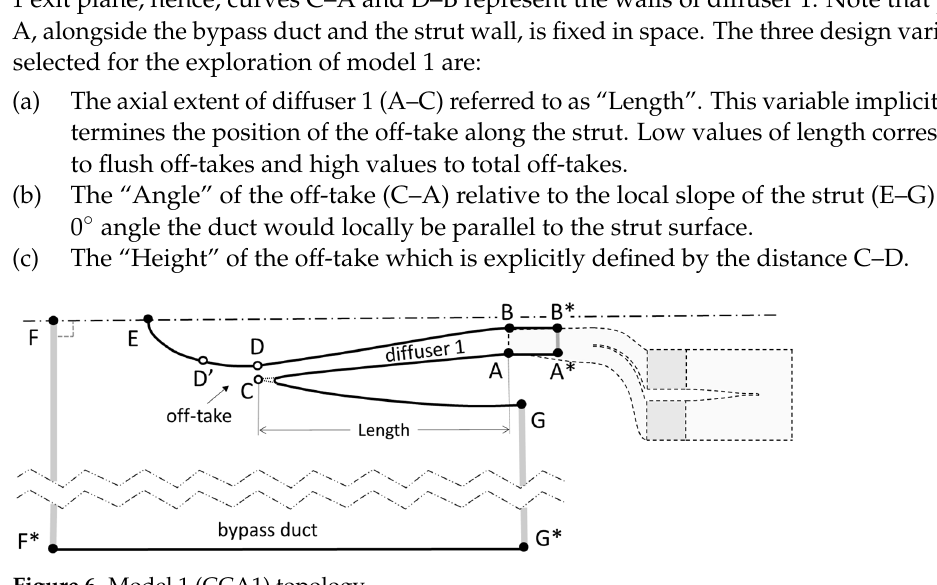
Figure 6. Model 1 (CCA1) topology.